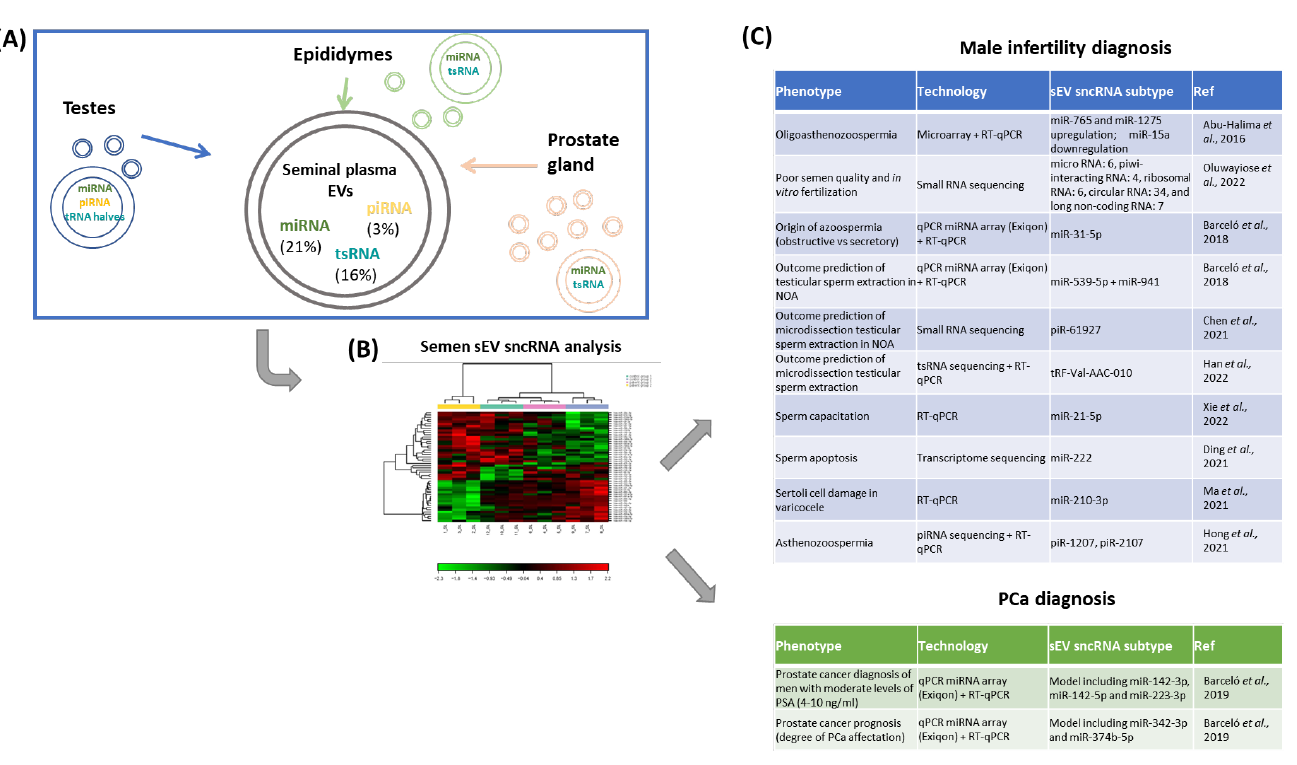
Figure 2. Uncovering semen EV sncRNAs as biomarkers for urogenital diseases. ( A ) Semen contains a heterogeneous composition of sEVs, released from the different organs of the male reproductive tract. This fact determines the proportion of the different sncRNA subtypes identified in semen sEVs as the profile of small RNA population varies between tissues in the male reproductive tract. ( B )